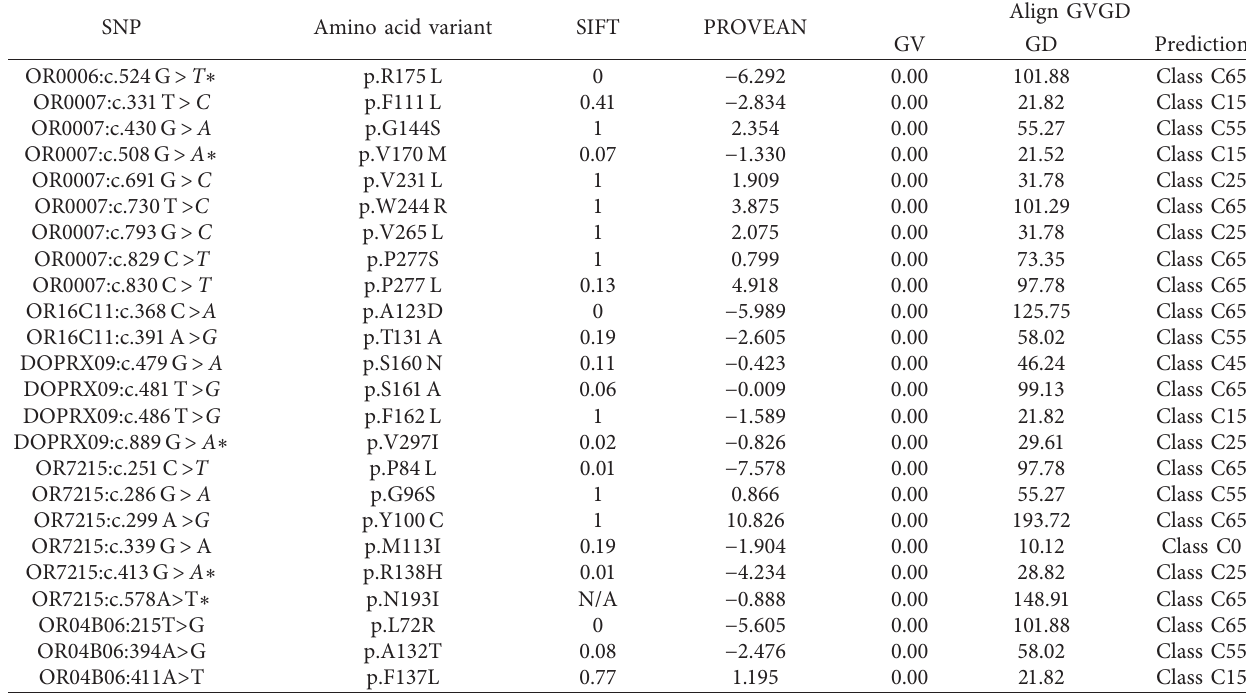
Align GVGD GV GD